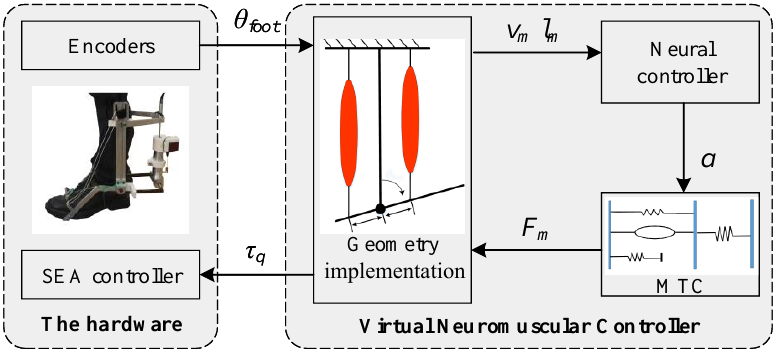
Figure 1. The overall architecture of the proposed bipedal robots upright balance control strategy.